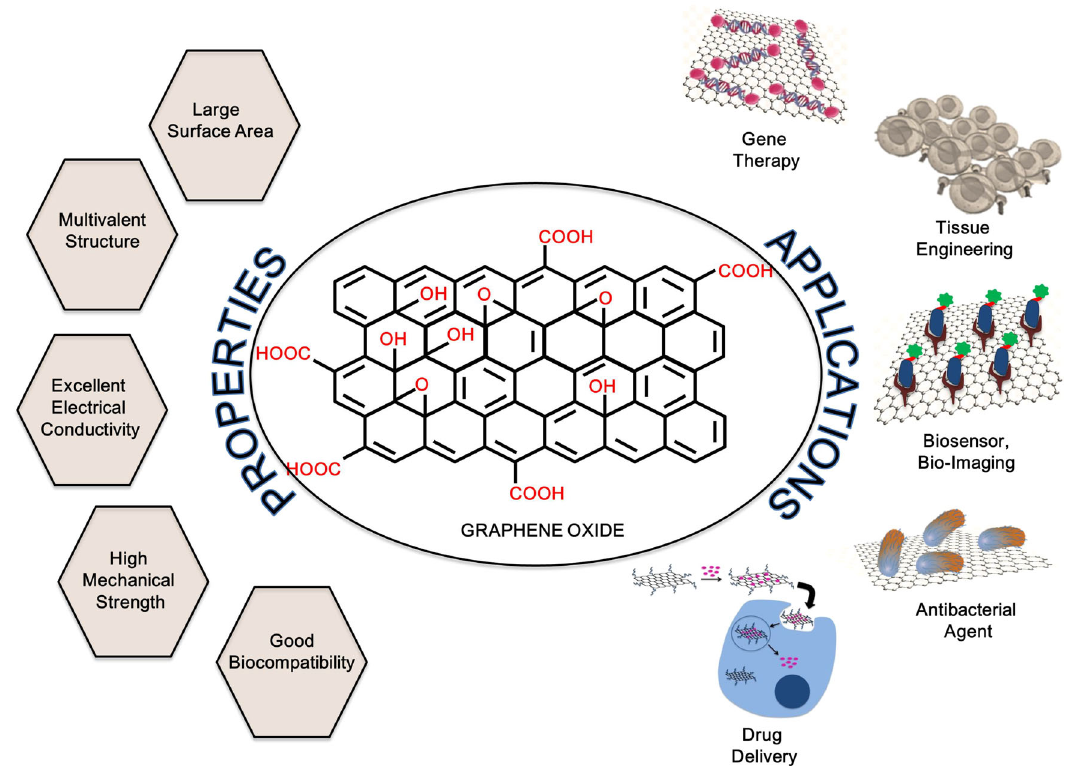
Fig. 2 Graphene oxide. The structure, properties, and applications of graphene